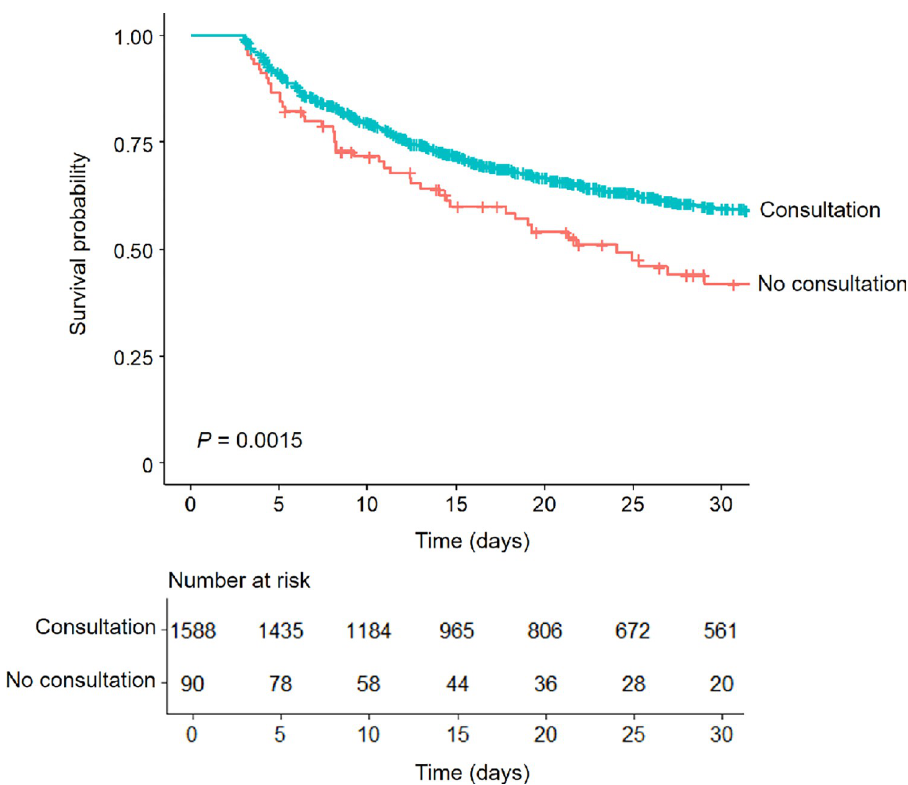
Fig 4. Kaplan-Meir survival curves between patients with and without consultation, excluding those who died within 72 hours after initiation of CRRT.